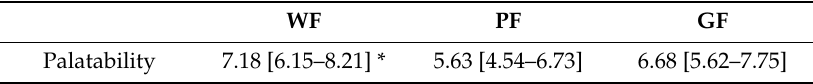
Table 5. Palatability ratings of the whole foods, processed and gluten-free meals. WF PF